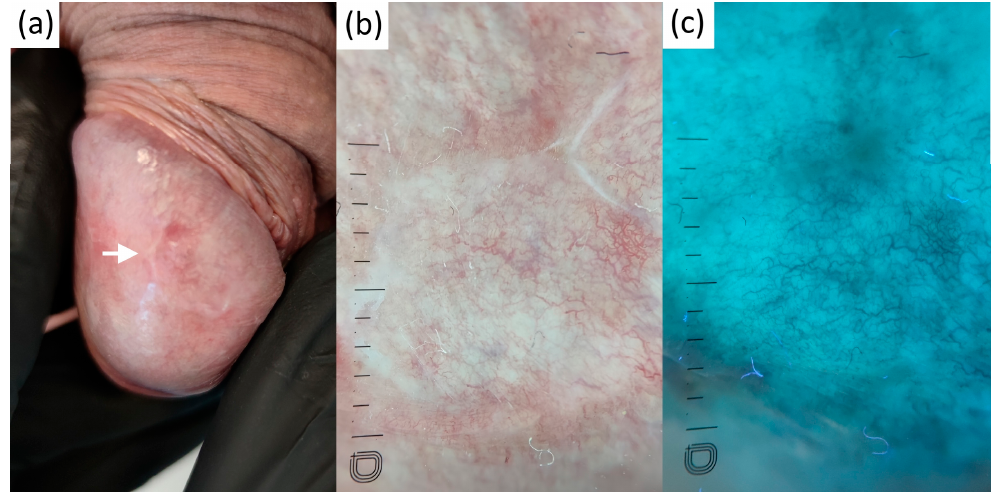
Figure 3. Clinical ( a ), contact-polarized ( b ), and ultraviolet-induced fluorescence ( c ) dermatoscopic images of genital lichen planus.